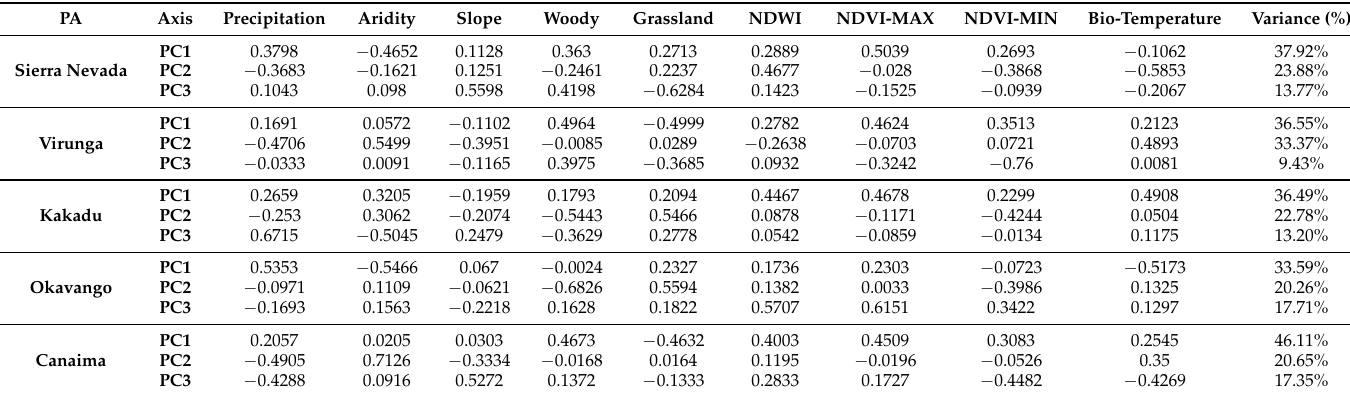
Table 2. Eigenvectors of each input variable corresponding to the first 3 PCA axes and the amount of variance explained by each axis at each study area. The description of the study variables can be found in Section